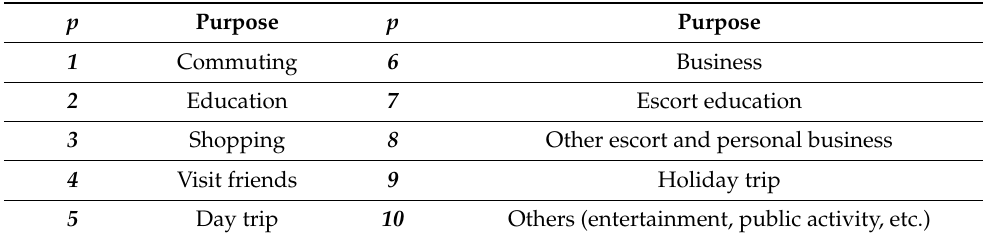
Table 1. Different trip